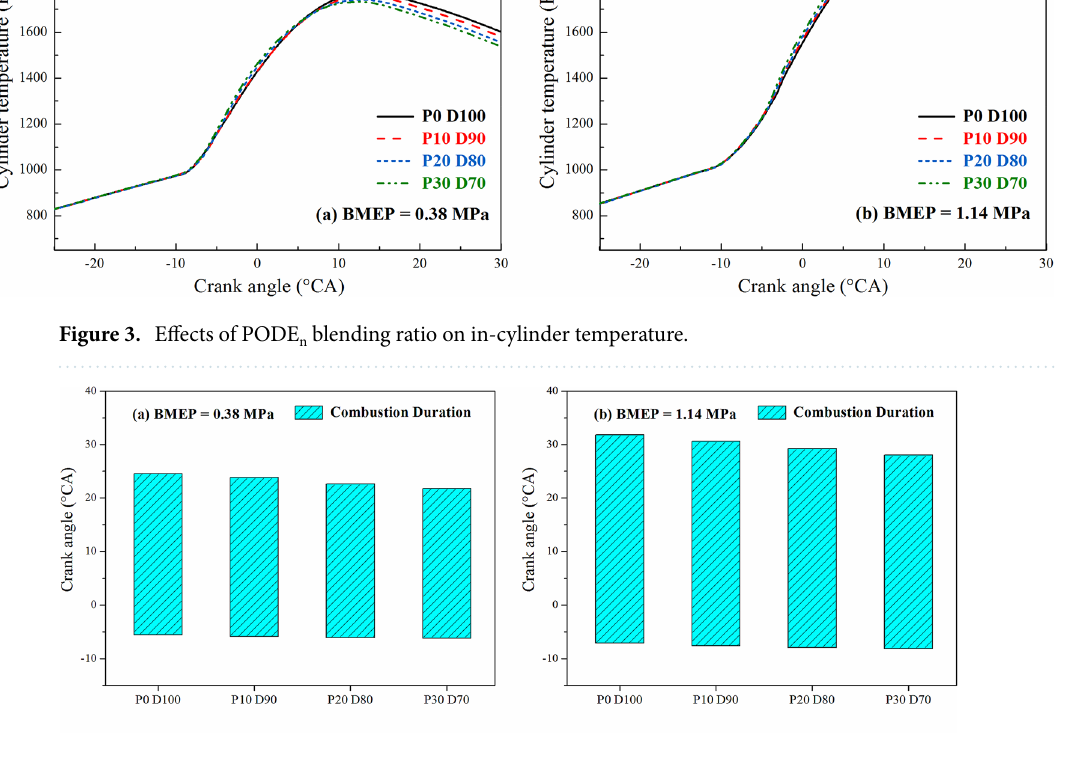
Figure 4. Effects of PODE n blending ratio on combustion duration.